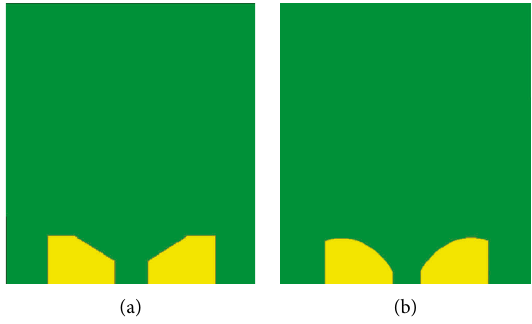
Figure 5: Evolution process of grounding plane. (a) Before the evolution. (b) After the evolution.